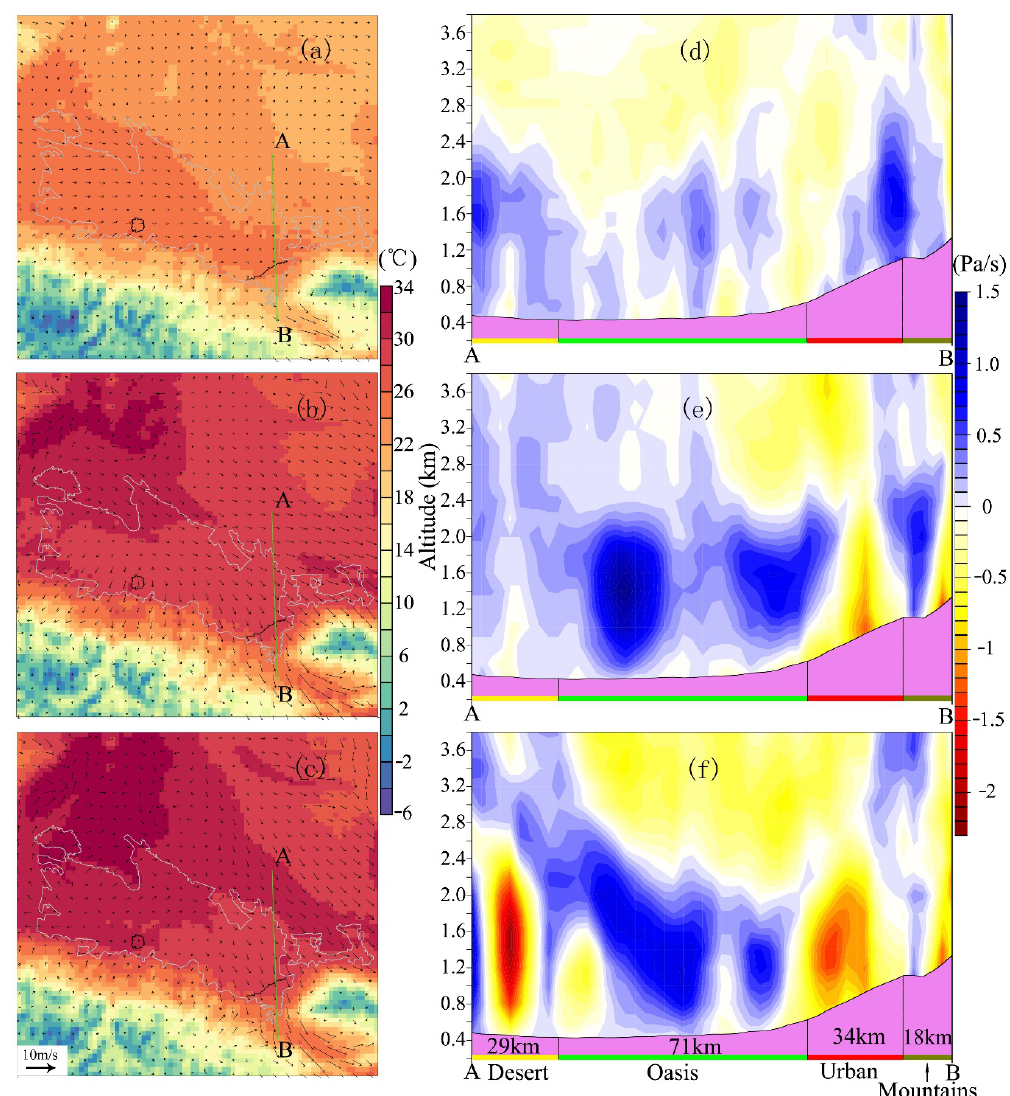
Figure 7. The spatial patterns of the simulated wind direction (vectors) and temperature (°C, shaded contours) at the lowest model level and their corresponding vertical velocity (Pa s − 1 ) cross section at 09:00 ( a , d ), 16:00 ( b , e ) and 21:00 ( c , f ) (Beijing Time, BJT) for 11 June 2016. The green line AB in ( a – c ) represents the location of the vertical cross section. In ( d – f ), the violet shaded areas at the bottom of each panel represent the terrain; along the x axis (from A to B), the yellow bar represents the extent of the desert; the green bar represents the extent of the oasis; the red bar represents the extent of the urban area; the olive green bar represents the extent of mountain areas and the number represents the width of the land use type.